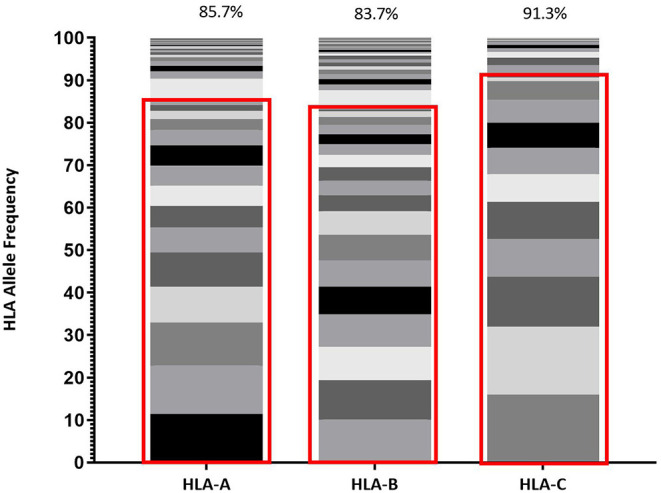
Frequency of each HLA Class I allele (HLA-A, HLA-B, and HLA-C) represented within IAVI Protocol C Alleles. Red boxes demarcate the allele frequencies contained within 13 pre-selected volunteers (Table 2) with percentage coverage listed above each stacked histogram plot. Seventeen Individual alleles contribute to HLA-A analysis, 21 Individual alleles contribute to HLA-B analysis, and 13 Individual alleles contribute to HLA-C analysis.